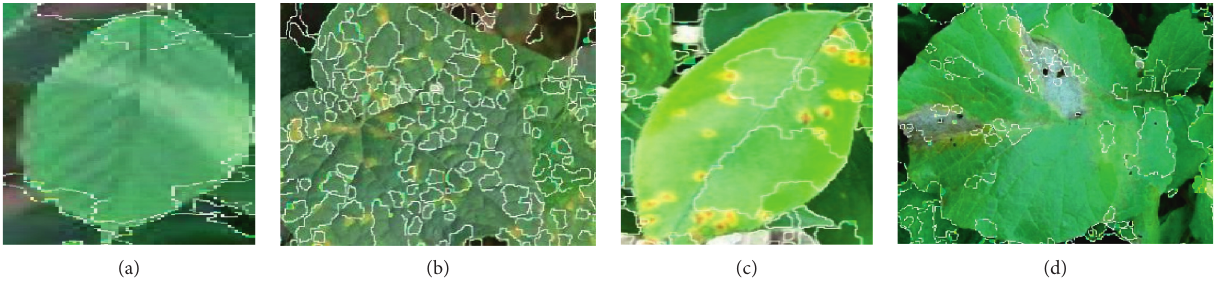
Figure 7: The result of watershed algorithm: (a) black rot disease; (b) bacteria plaque disease; (c) rust disease; (d) healthy